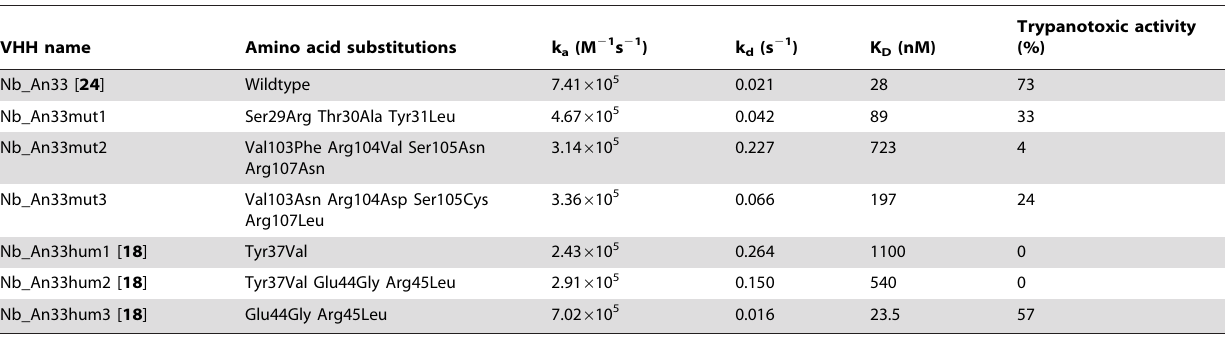
Table 1. Characteristics of the Nb_An33